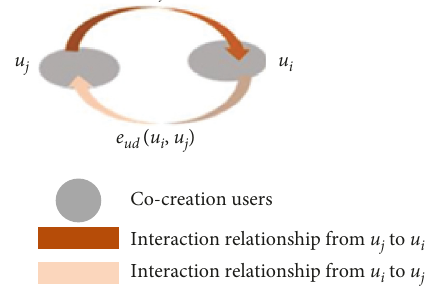
Figure 3: Co-creation user interaction network.